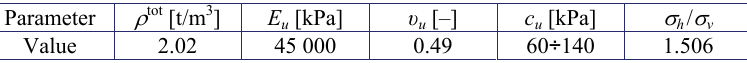
Table 3. CEL model parameters with linear elasticity and Tresca